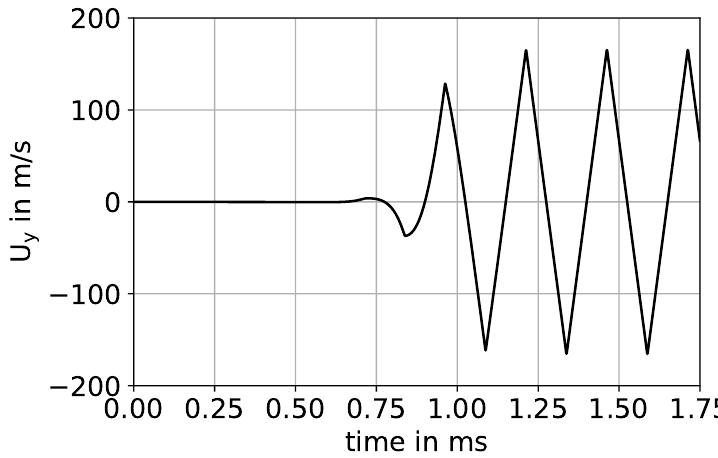
Figure 5. Temporal evolution of the velocity U y of the superposed oscillation on the nozzle inflow boundary, representing the OsciJet